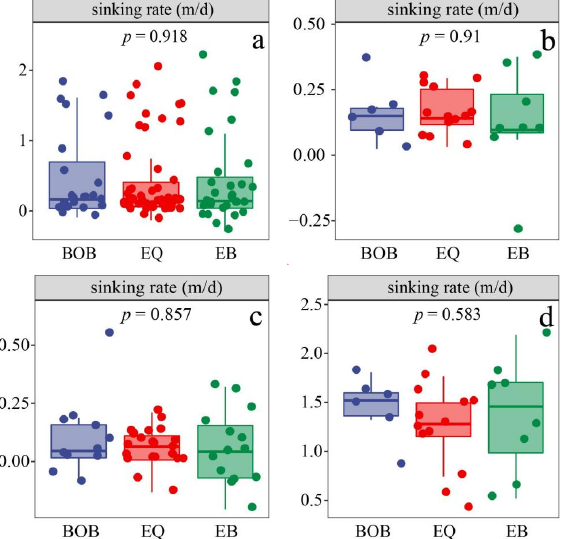
Figure 6. The sinking rates in different sub-regions of the eastern Indian Ocean in spring 2017. ( a ) The average sinking rates in the three sub-regions. ( b ) The average sinking rates of the surface layer (3 m and 25 m) in the three sub-regions. ( c ) The average sinking rates of the middle layer (50 m, 75 m and 100 m) in the three sub-regions. ( d ) The average sinking rates of the bottom layer (150 m and 200 m) in the three